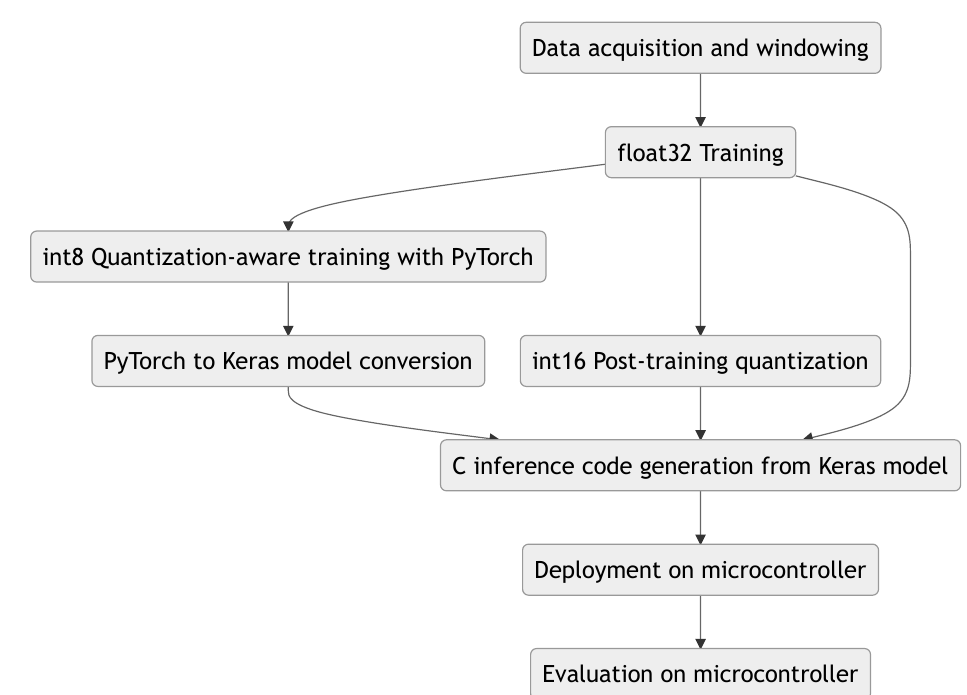
Figure 3. MicroAI general flow for neural network quantization and evaluation on embedded